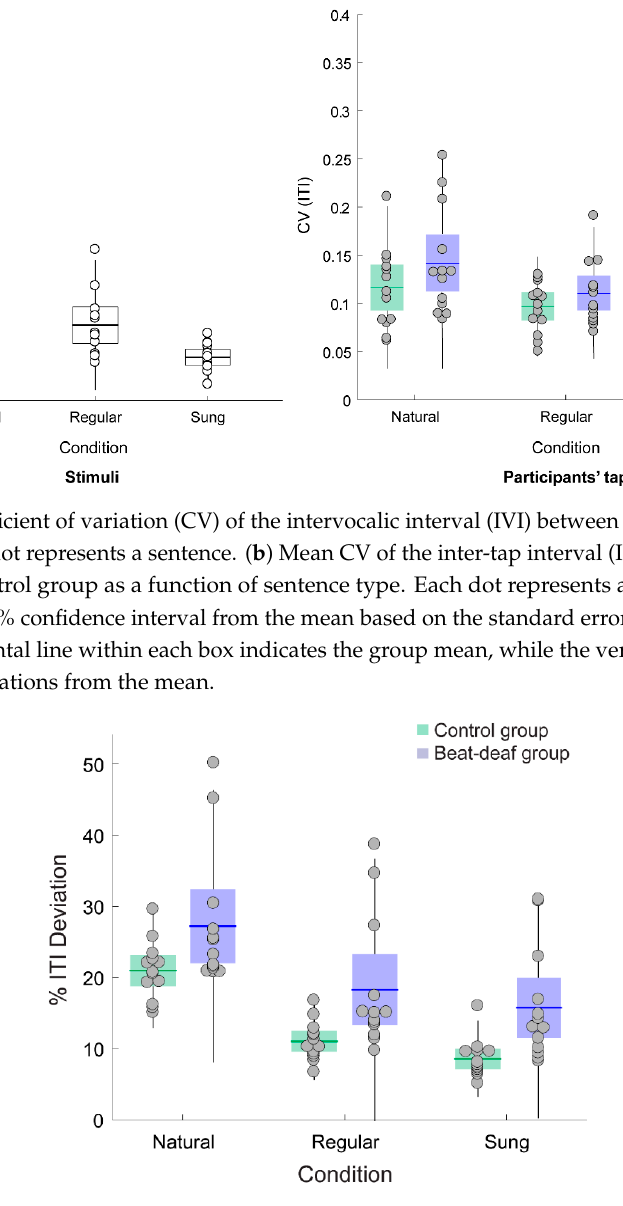
Figure 4. Mean percentage of deviation between the inter-tap intervals (ITIs) produced by each participant and the IVIs of the sentences. Each dot represents a participant. Boxes corresponds to a 95% confidence interval from the mean based on standard error mean (SEM). The black horizontal line within each box indicates the group mean. The vertical lines represent two standard deviations from the mean.